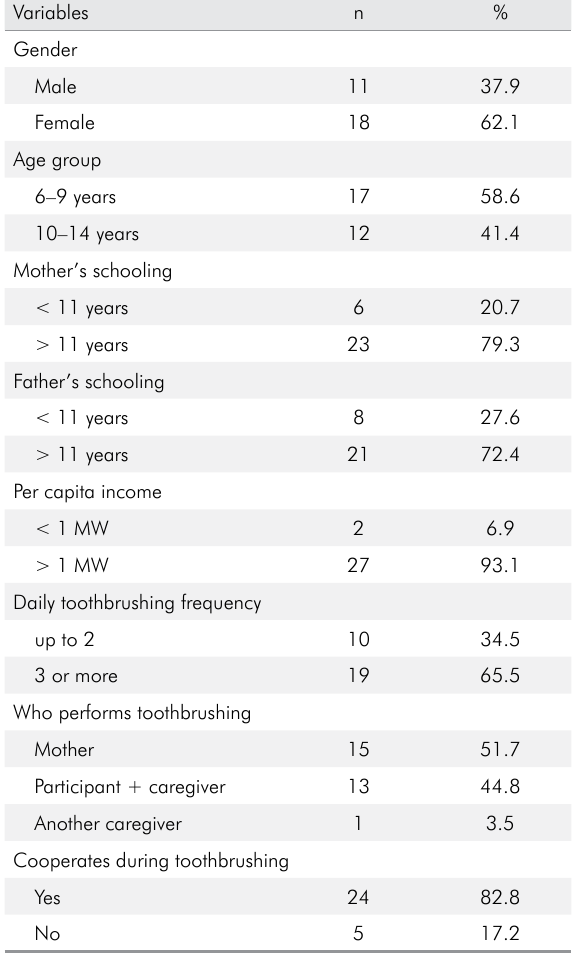
Table 1. Socioeconomic data and oral health habits of children and teenagers with Down